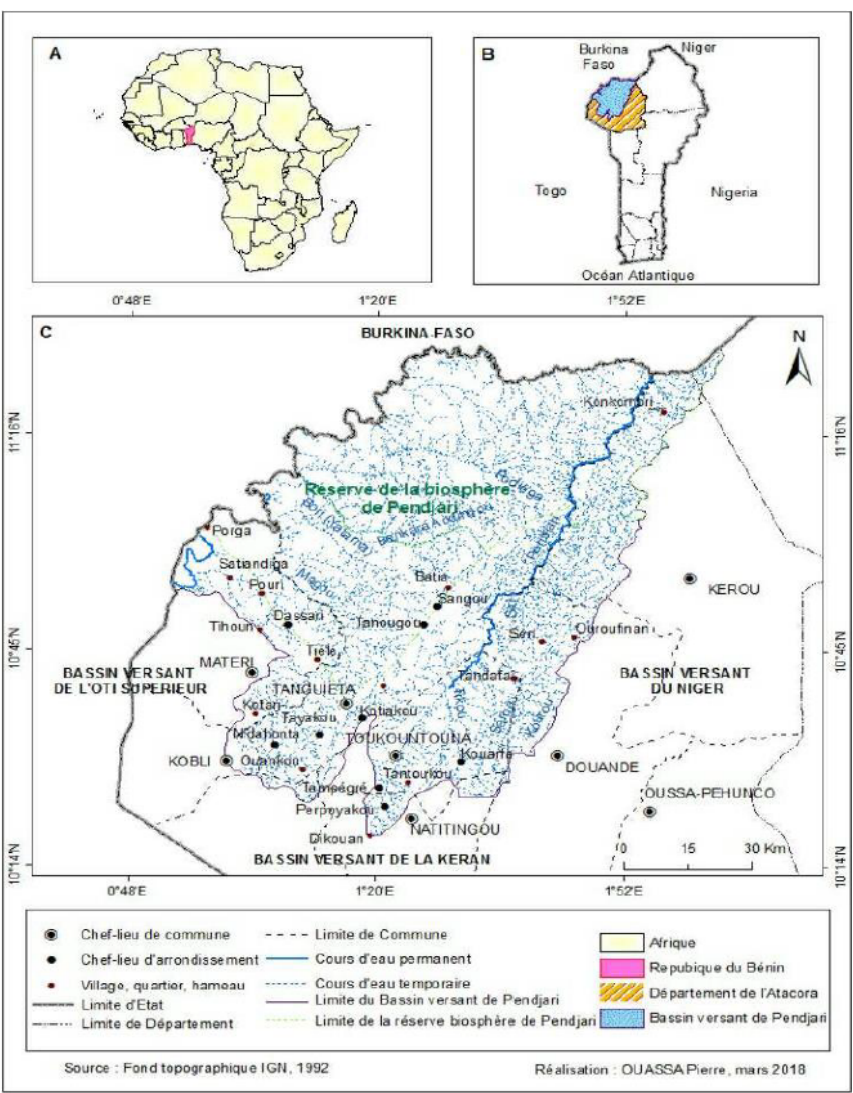
Figure 1. Situation géographique du bassin Béninois de la Pendjari à l’exutoire de